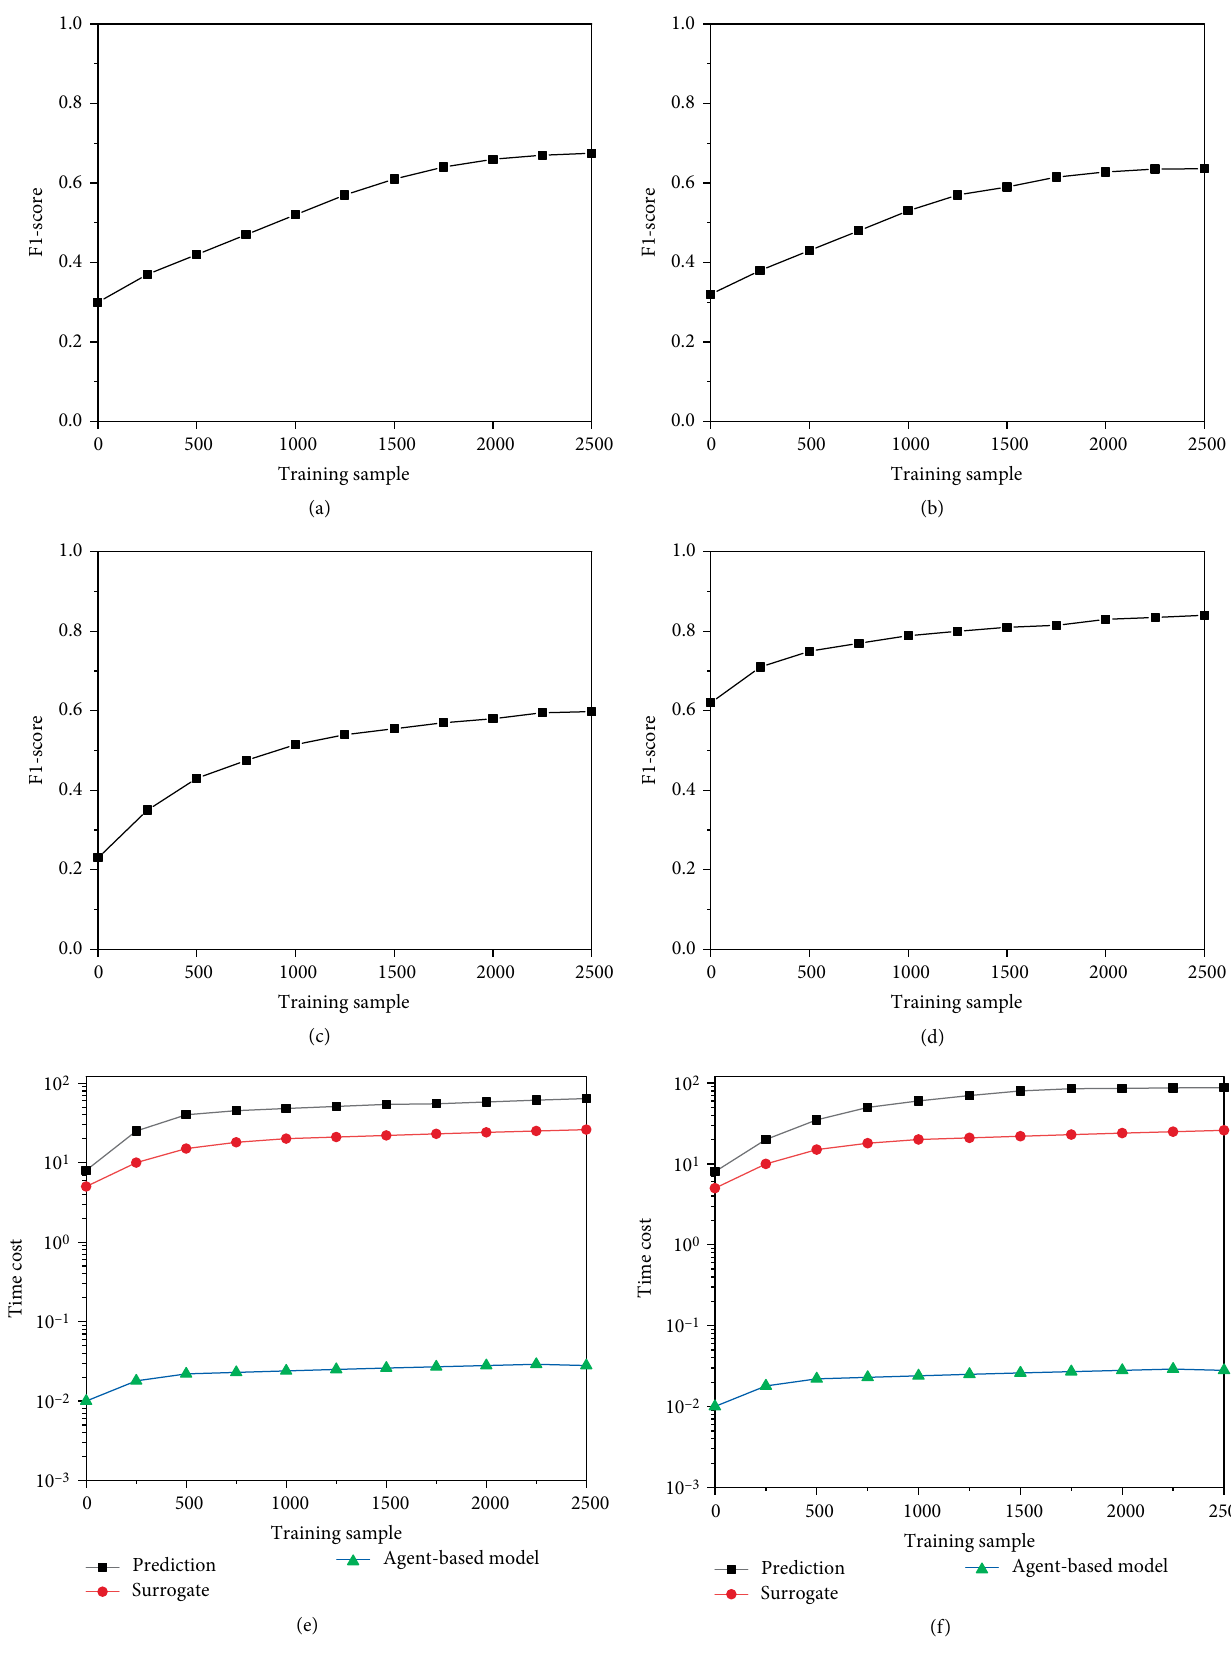
Figure 4: Surrogate analysis results of the HAM model. (a) F1 score of the binary case. (b) MSE of the real-value case. (c) TPR of the binary case. (d) TPR of the real-value case. (e) Time costs of the binary case. (f) Time costs of the real-value